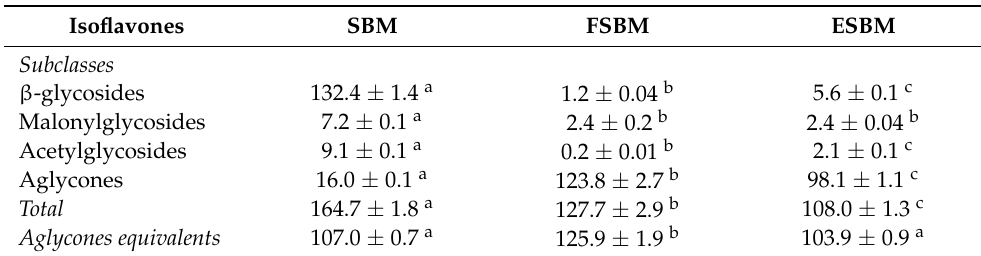
Table 2. Contents of isoflavones and their subclasses (mg/100 g) in soybean meal (SBM), fermented soybean meal (FSBM) and enzymatically-processed soybean meal (ESBM) 1 . Isoflavones SBM